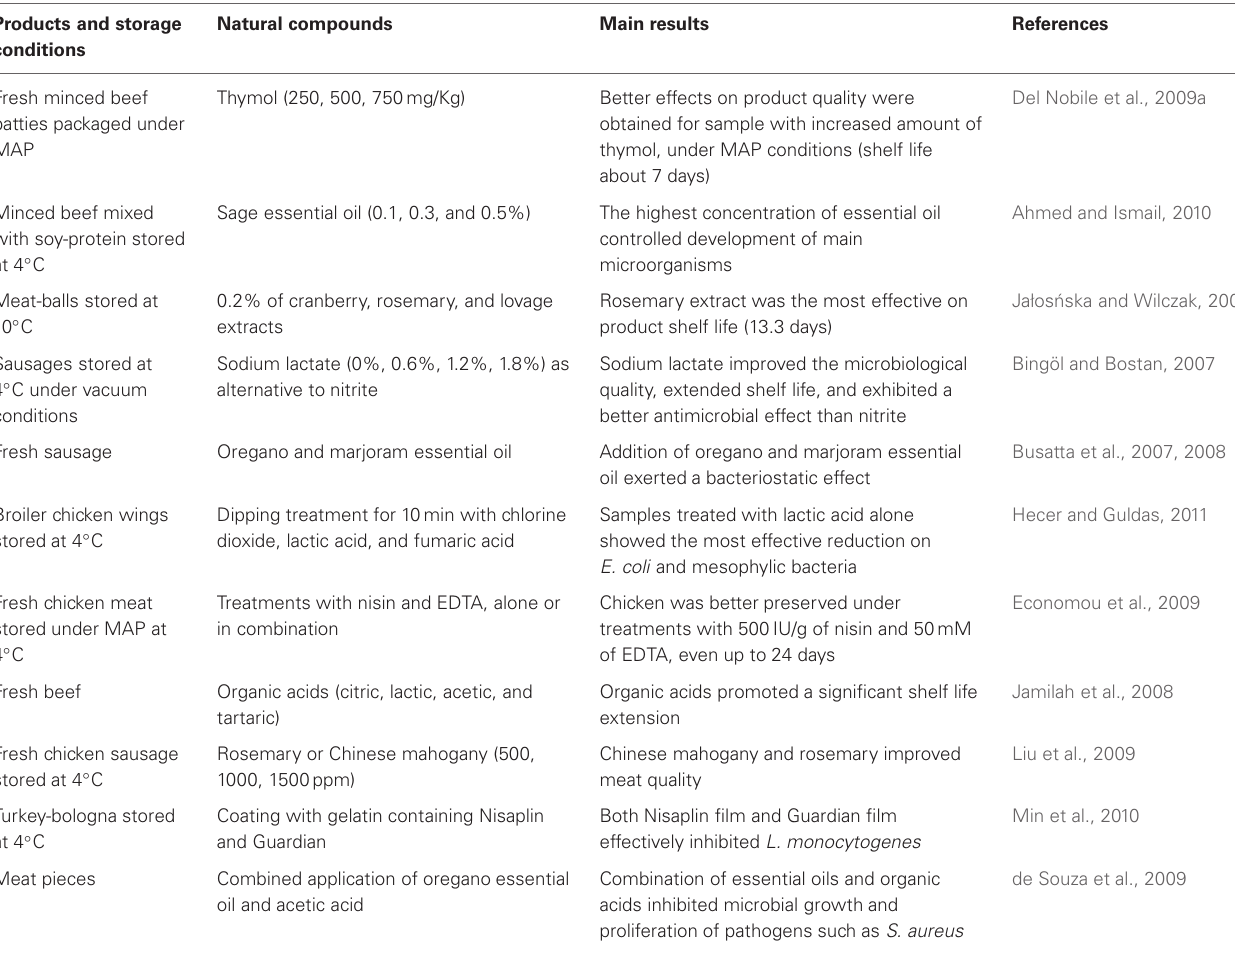
Table 3 | Relevant examples of natural active agents applied to meat-based